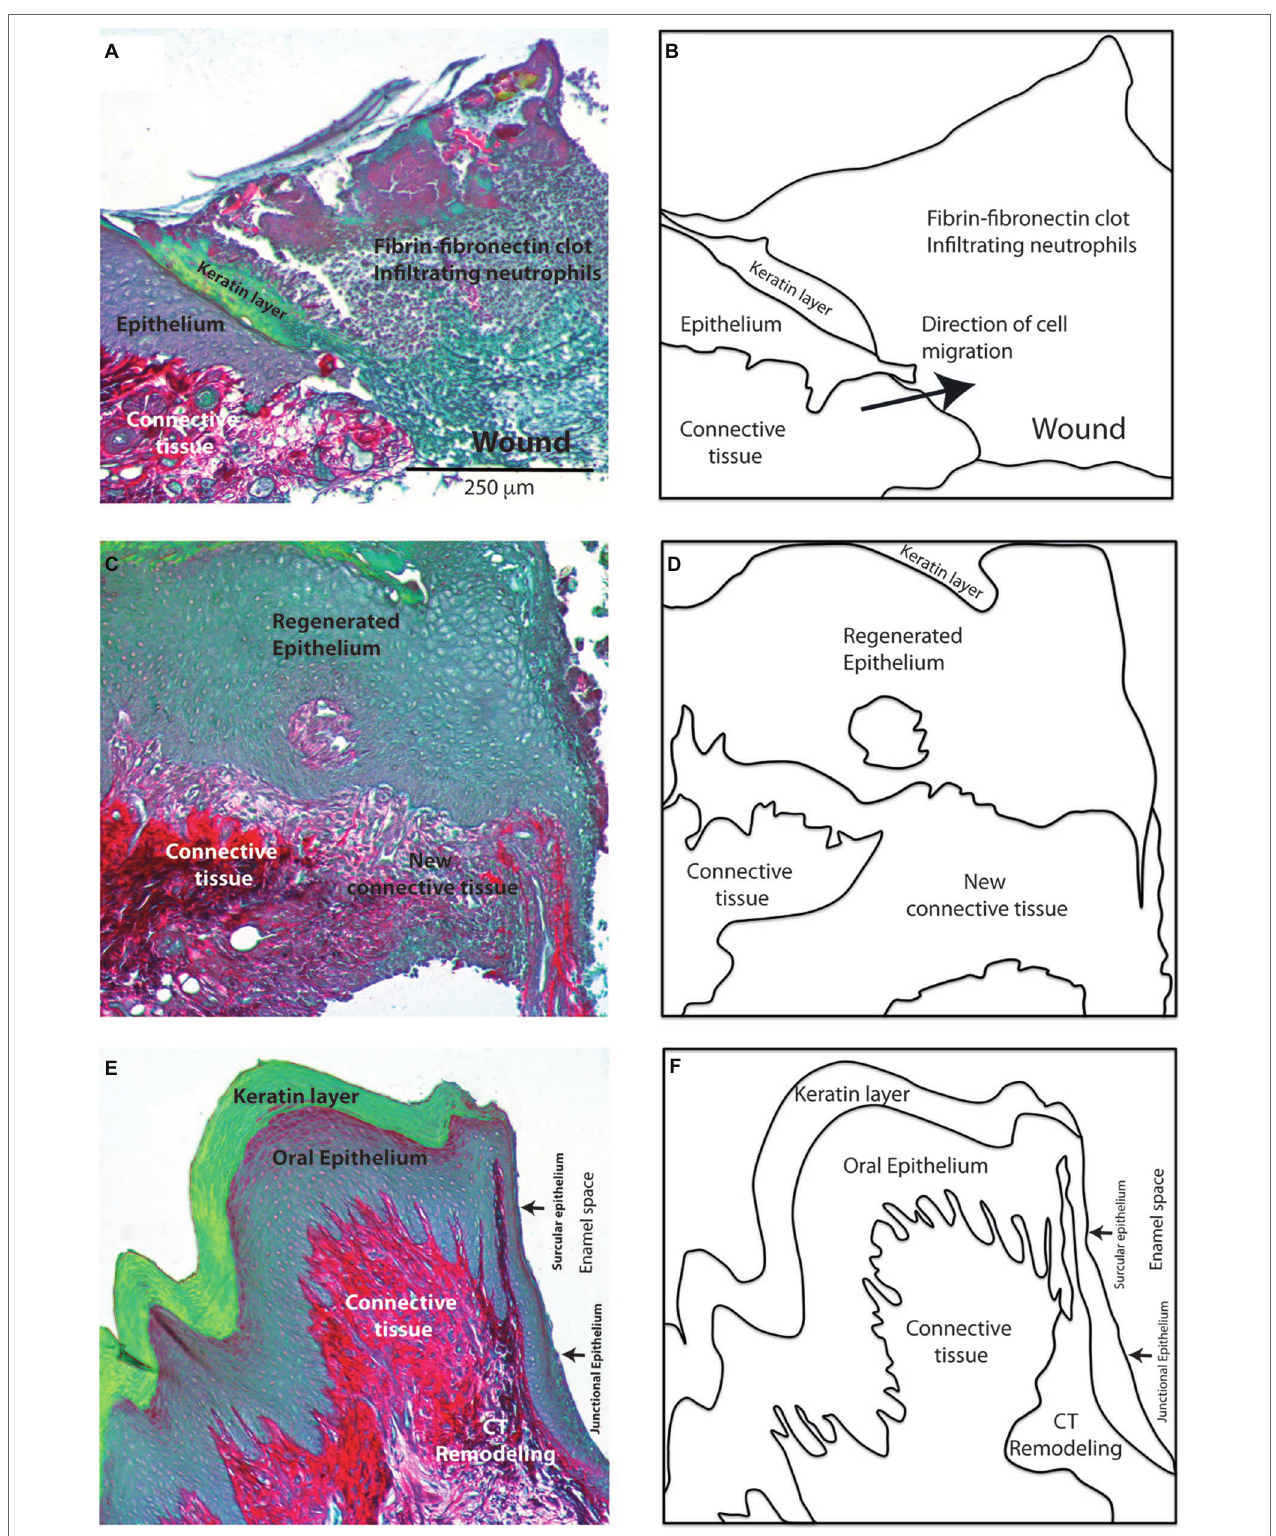
FIGURE 2 | Morphological features of periodontal wound healing. Histological sections stained with sirius red show the collagen network (red). Images show the main histological changes in 2 (A) , 7 (C) and 15 (E) day old gingival wounds. Diagrams in (B) , (D) , and (F) show the main tissues involved in these responses. Magnification bar = 250 μ